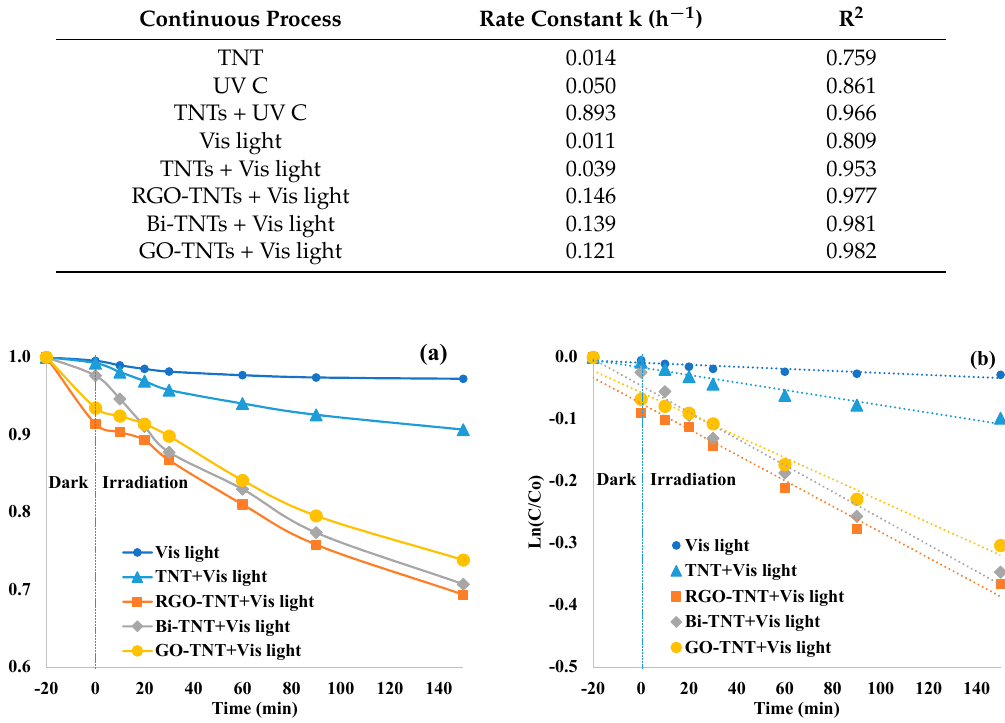
Figure 6. Photocatalytic degradation of MB dye in a continuous ‐ flow reactor over Vis light, TNTs + Vis light, RGO ‐ TNTs + Vis light, Bi ‐ TNTs + Vis light, and GO ‐ TNTs + Vis light: ( a ) C/C 0 and ( b ) ln(C/C 0 ).